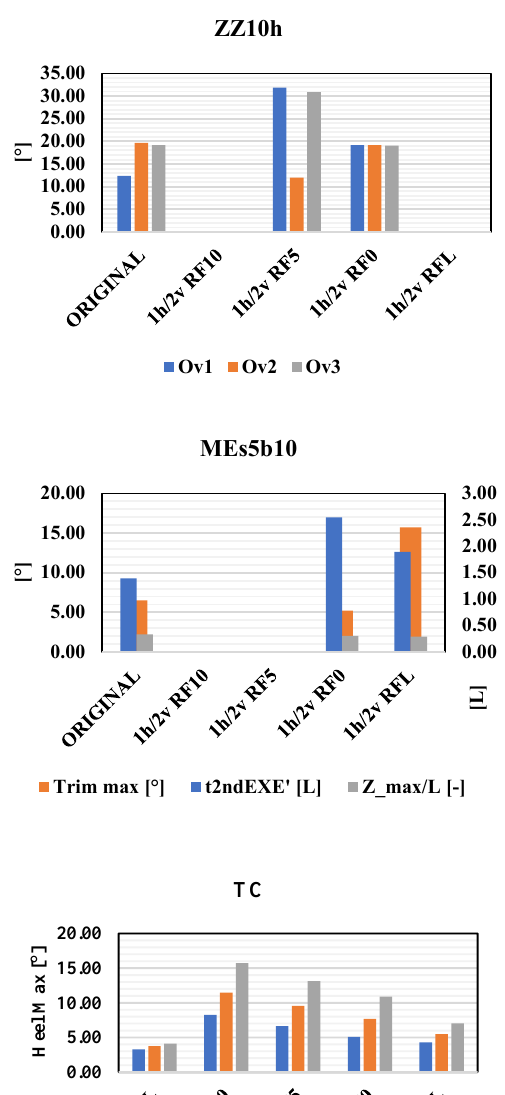
Figure A7. SMG +-Eq Failures.